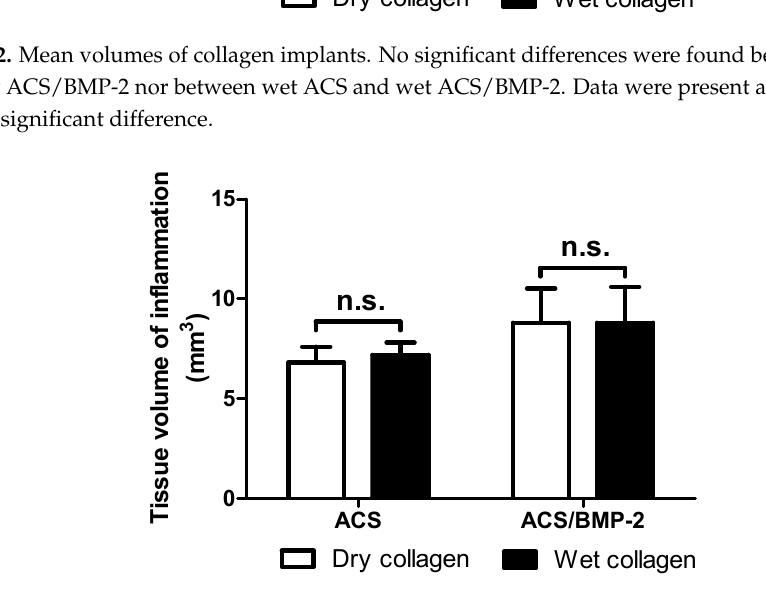
Figure 3. Periimplant inflammation volume. No significant differences were found between dry ACS and dry ACS/BMP-2 nor between wet ACS and wet ACS/BMP-2. Data were present as Means ± SEM. n.s.: no significant difference.